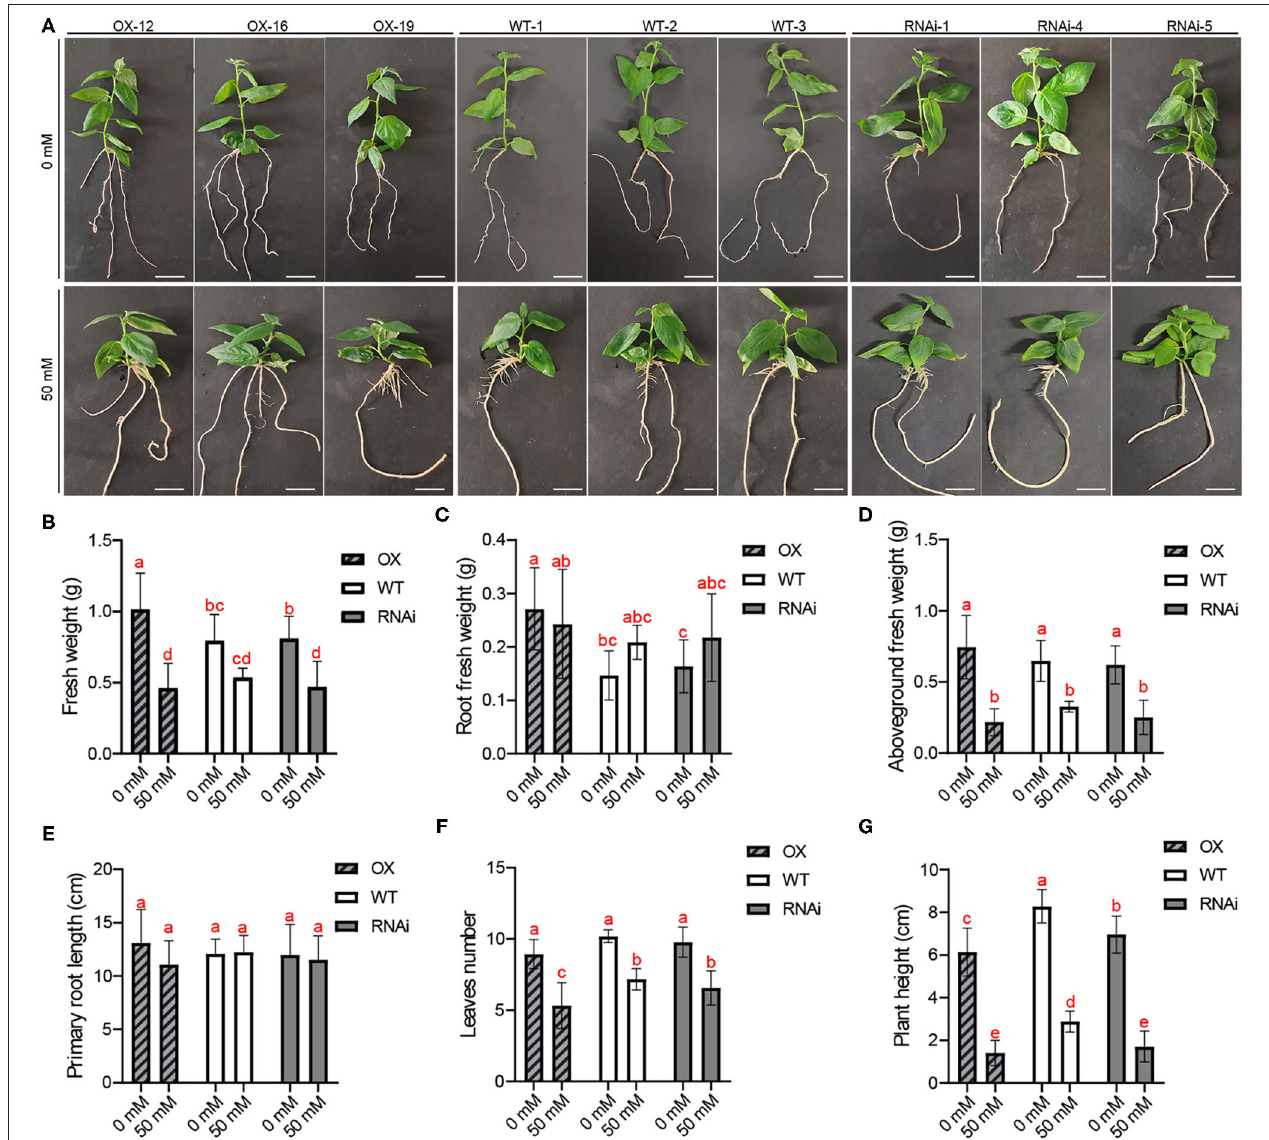
FIGURE 2 | PagERF16 was sensitive to salt stress. (A) Morphology of the OX, RNAi, and WT grown on medium containing 50mM NaCl for 30 d. Bars, 2cm. (B) Fresh weight of whole plant. (C) Root fresh weight. (D) Fresh weight of aboveground tissues. (E) Length of primary root. (F) Numbers of leaves per plant. (G) Height of plant. The plot represents the mean ± SD of six plants per line. Three OX and RNAi lines serve as three biological repeats, respectively. Different lowercases indicate significant differences among samples ( p ≤